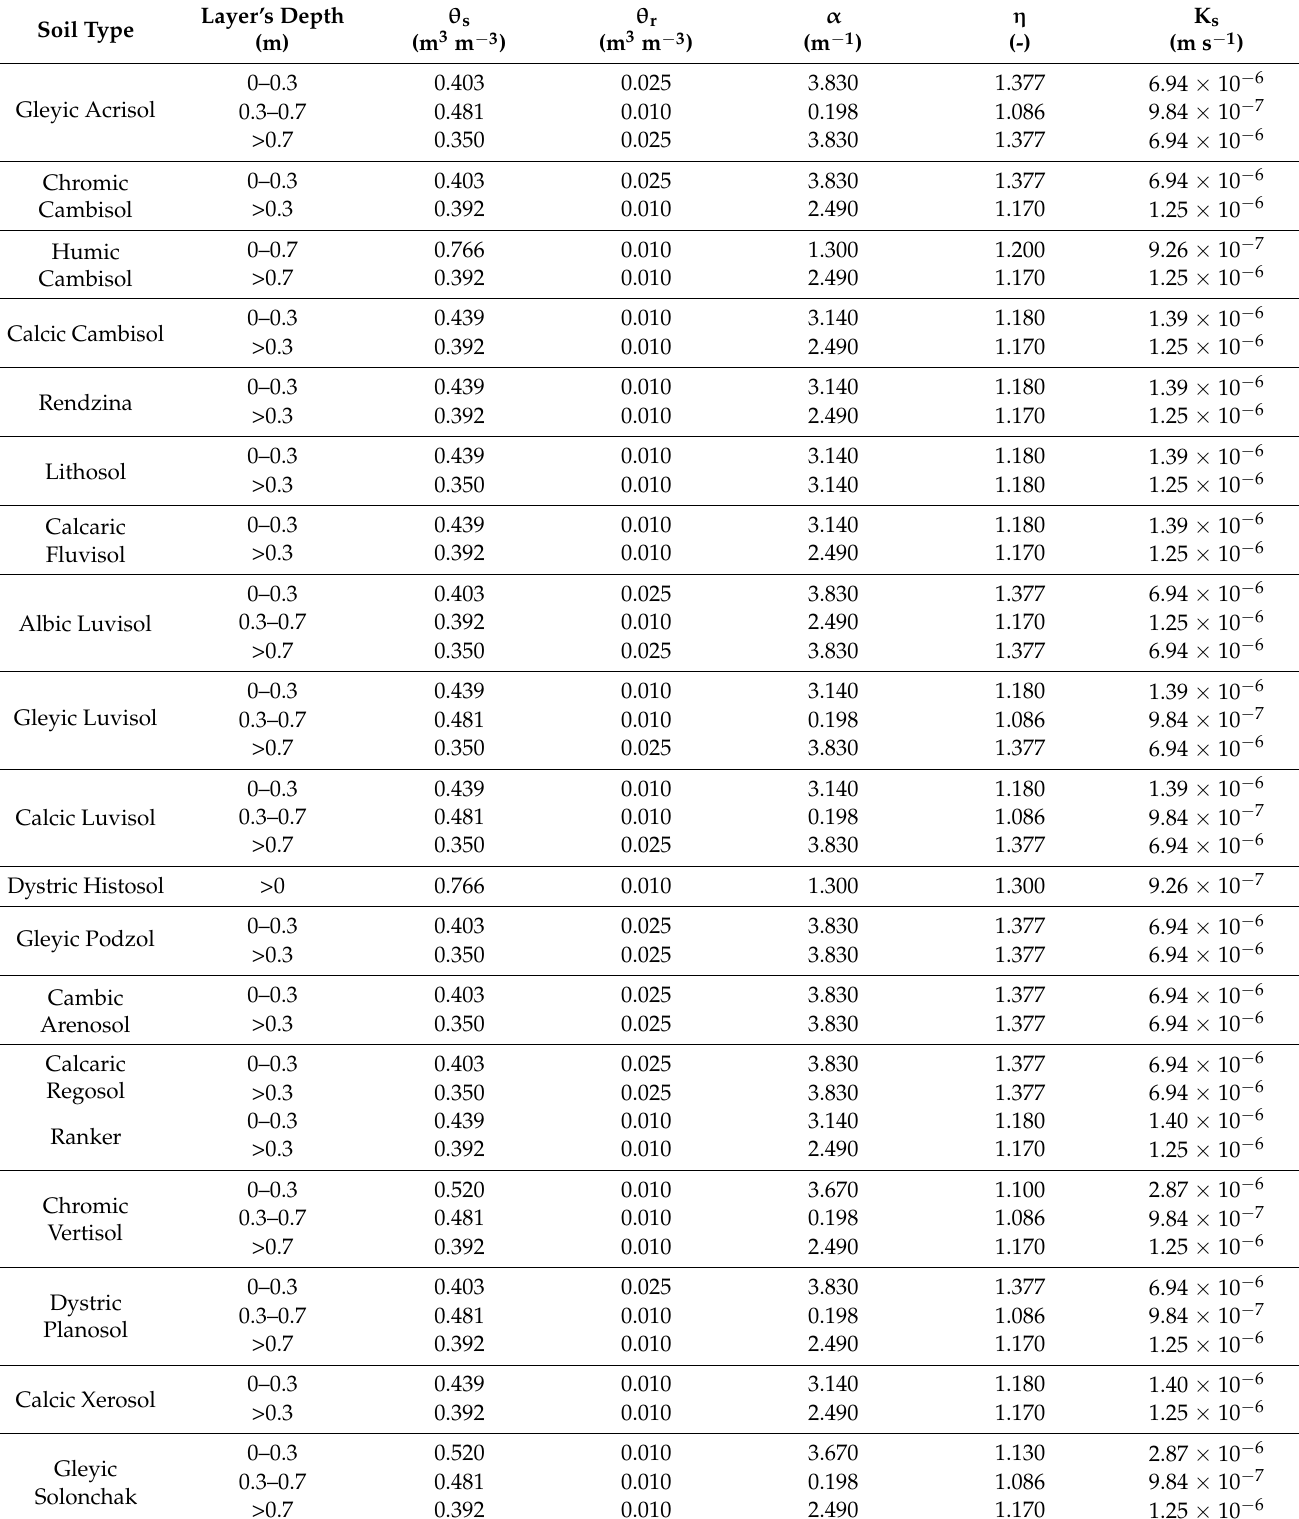
Table A2. Soil hydraulic